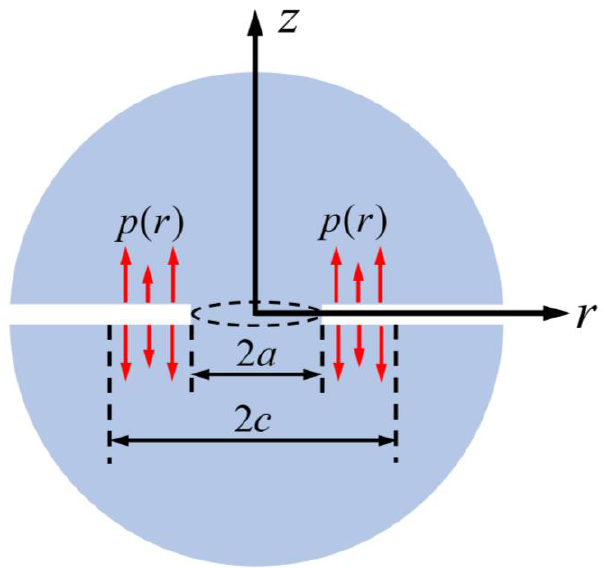
Figure A1. Schematic illustration of an external circular crack contained in an infinite transversely isotropic piezoelectric solid.